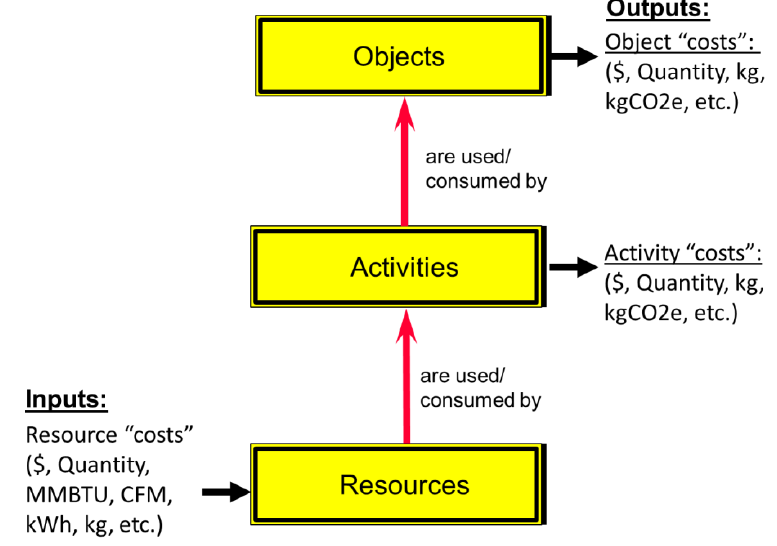
Figure 1. Multi-dimensional ABC to trace resource and activity consumptions using each